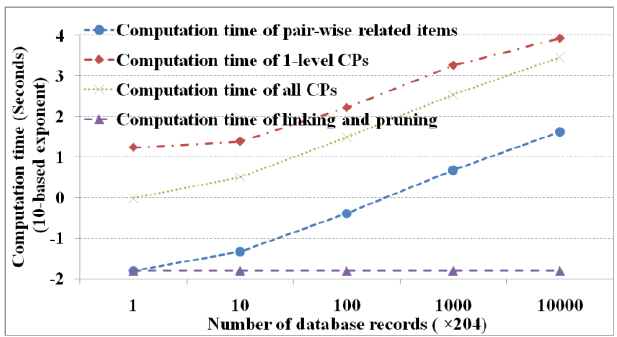
Figure 6. Performance analysis with different record numbers.